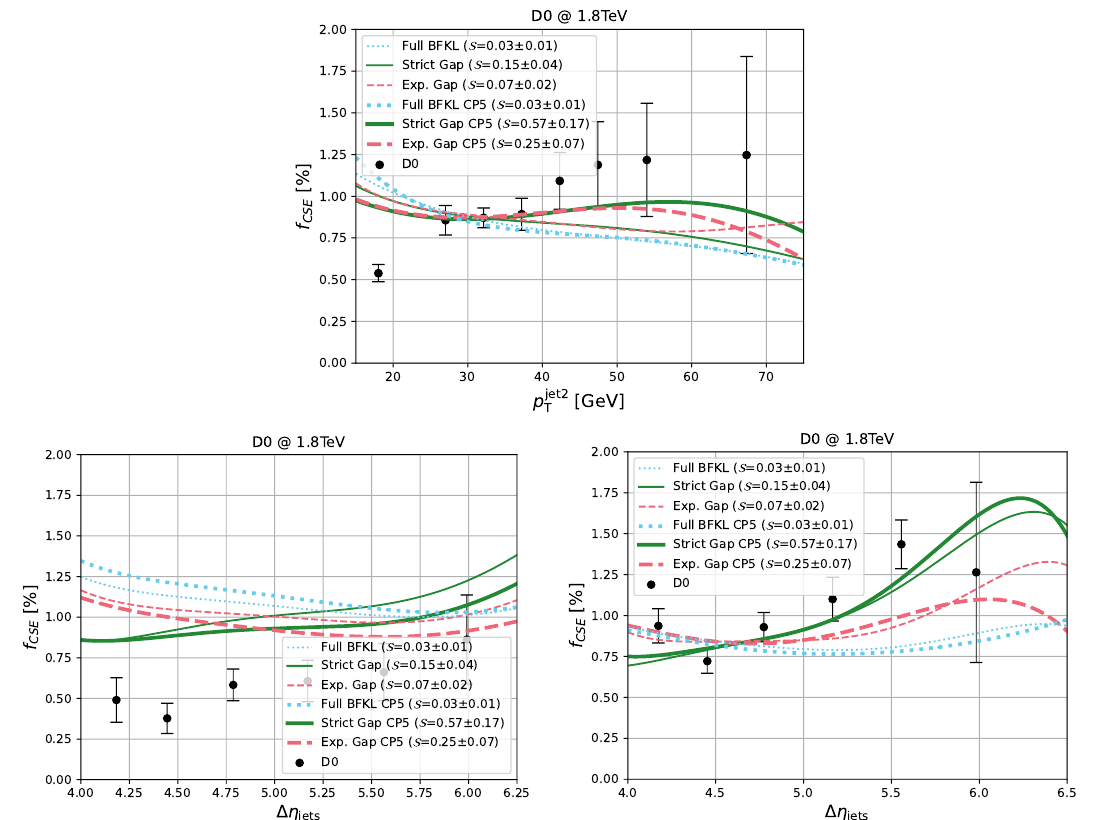
(top) and ∆ η with p jet2 Figure 4 . Predictions for f CSE as a function of p jet2 ∈ [15; 25] GeV jets T T (bottom left) and > 30 GeV (bottom right) compared to the D0 measurement at 1.8 TeV [12] for three different gap definitions (different line shapes), using the modified tune CP1 (with rapidity ordering, without MPI, thin lines) and the tune CP5 (with rapidity ordering, with MPI, thick lines). nificant rise towards larger ∆ η for both low p jet2 ∈ [15; 25] GeV (bottom left) and high jets T p jet2 > 30 GeV (bottom right). The results for medium p jet2 ∈ [25; 30] GeV, also measured T T by D0, are not shown. The fitted static scale factors (thin curves) are in agreement with those found for CDF within errors. Again the PYTHIA8 MPI (thick curves) cannot